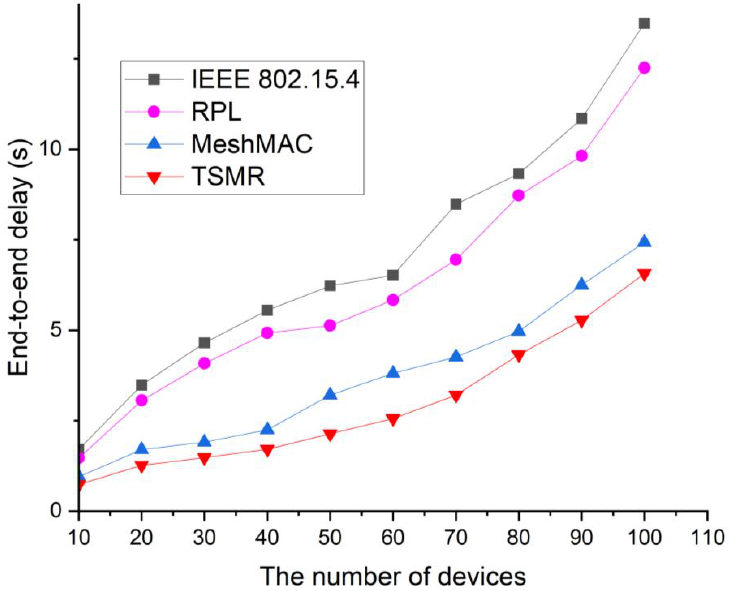
Figure 16. End-to-end delay as a function of the network size.